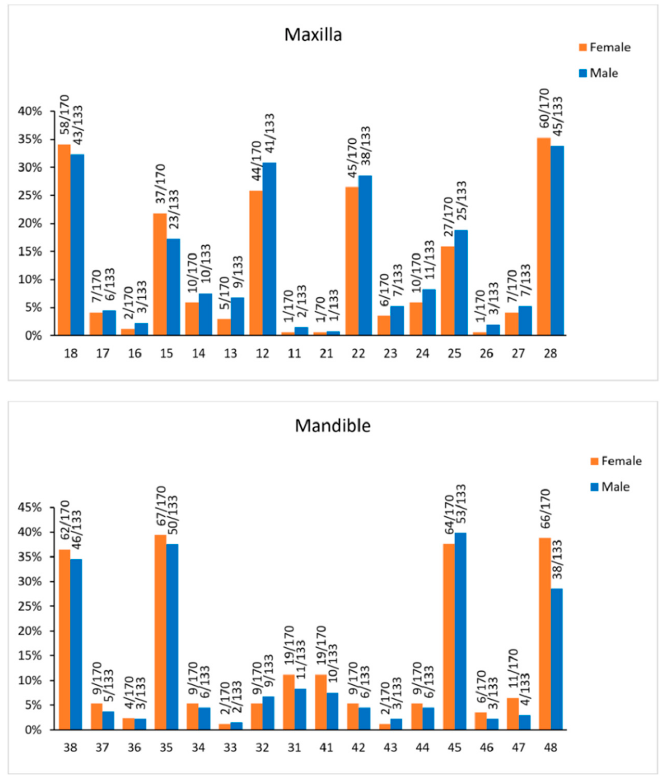
Figure 3. The number of missing teeth when considering all the teeth in the dentition including the third molars. 3.2. Comparison of Sexual Dimorphism in Third Molar Agenesis between Group A and Group B In Group B, which was matched for age and sex to Group A but included individuals without agenesis of any tooth apart from the third molars, 60 third molars were missing in males (prevalence 11.3%) and 84 in females (prevalence 12.4%) ( p = 0.592). The average number of third molar agenesis per individual in Group B was 0.45 ± 1.10 in males and 0.49 ± 1.07 in females ( p > 0.01). Similar to Group A, there was no sexual dimorphism in Group B when considering the distribution of third molar agenesis within jaws or quad- rants ( p > 0.006, Table 5, Table S1). Furthermore, there were no differences within sexes in the type of third molar missing when comparisons were performed between or within jaws (p > 0.01, Figure 1, Table S2).